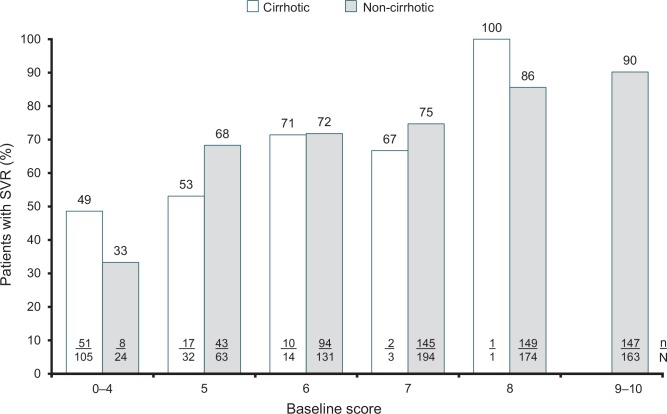
Rate of response in treatment-naive cirrhotic and noncirrhotic Caucasian and patients with HCV genotype 3 by baseline score.Patients with missing scores omitted (noncirrhotic; n = 48, cirrhotic; n = 11). a Patients with missing information on cirrhosis status were given the same score as no cirrhosis.